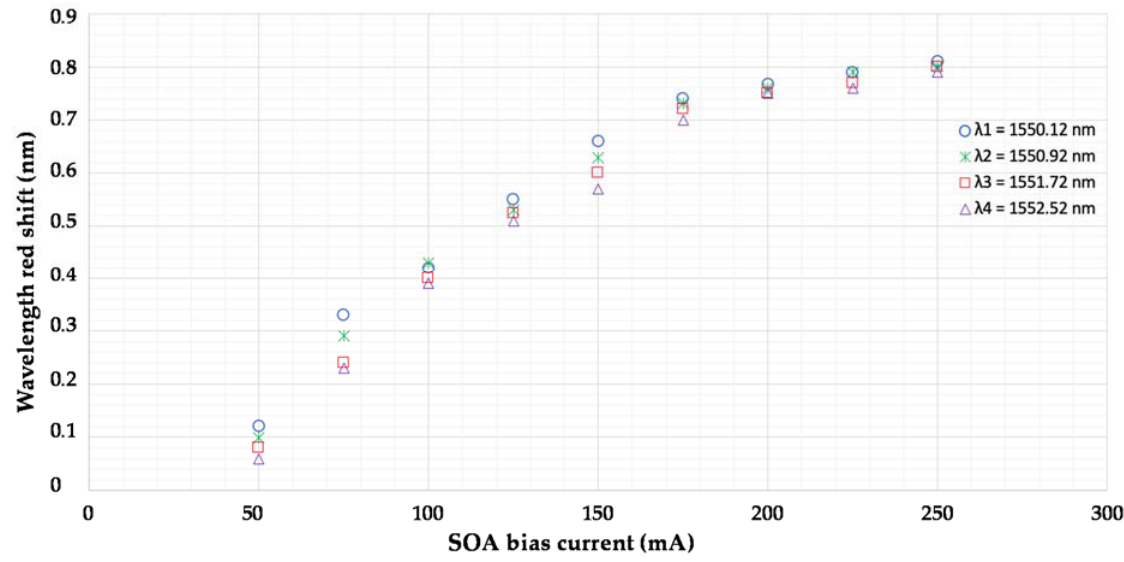
Figure 5. The measured amount of code carriers’ wavelength redshift as a function of the SOA bias current.